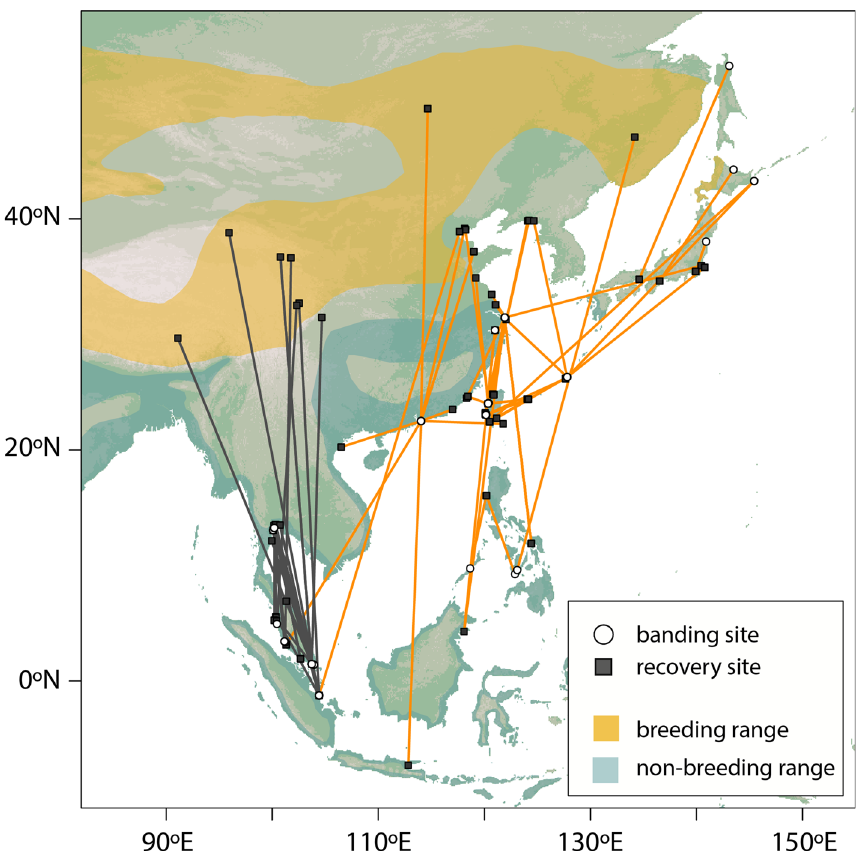
Figure 1. Migration routes of Common Redshanks wintering in Southeast Asia, based on ring recoveries and flag observations. Solid lines between banding and recovery sites are used to indicate the migration route. Black colour indicates birds breeding on the Qinghai-Tibet Plateau; Orange colour indicates birds breeding in East Mongolia, Northeast China and the Russian Far East. Data are derived from Supplementary Table S1. Map Source: ETOPO1 1 Arc-Minute Global Relief Model dataset provided by NOAA https ://www.ngdc.noaa.gov/ mgg/globa l/globa l.html. Species distribution map provided by BirdLife